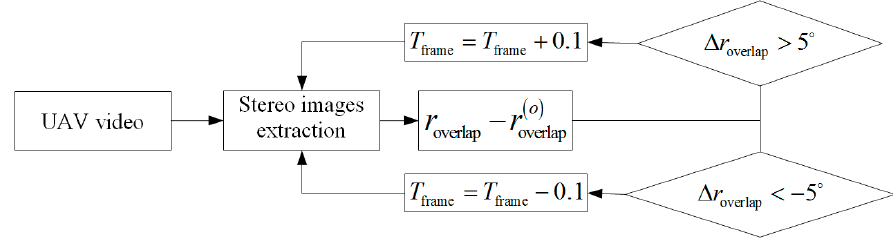
Figure 8. Validation of overlap for stereo image extraction.